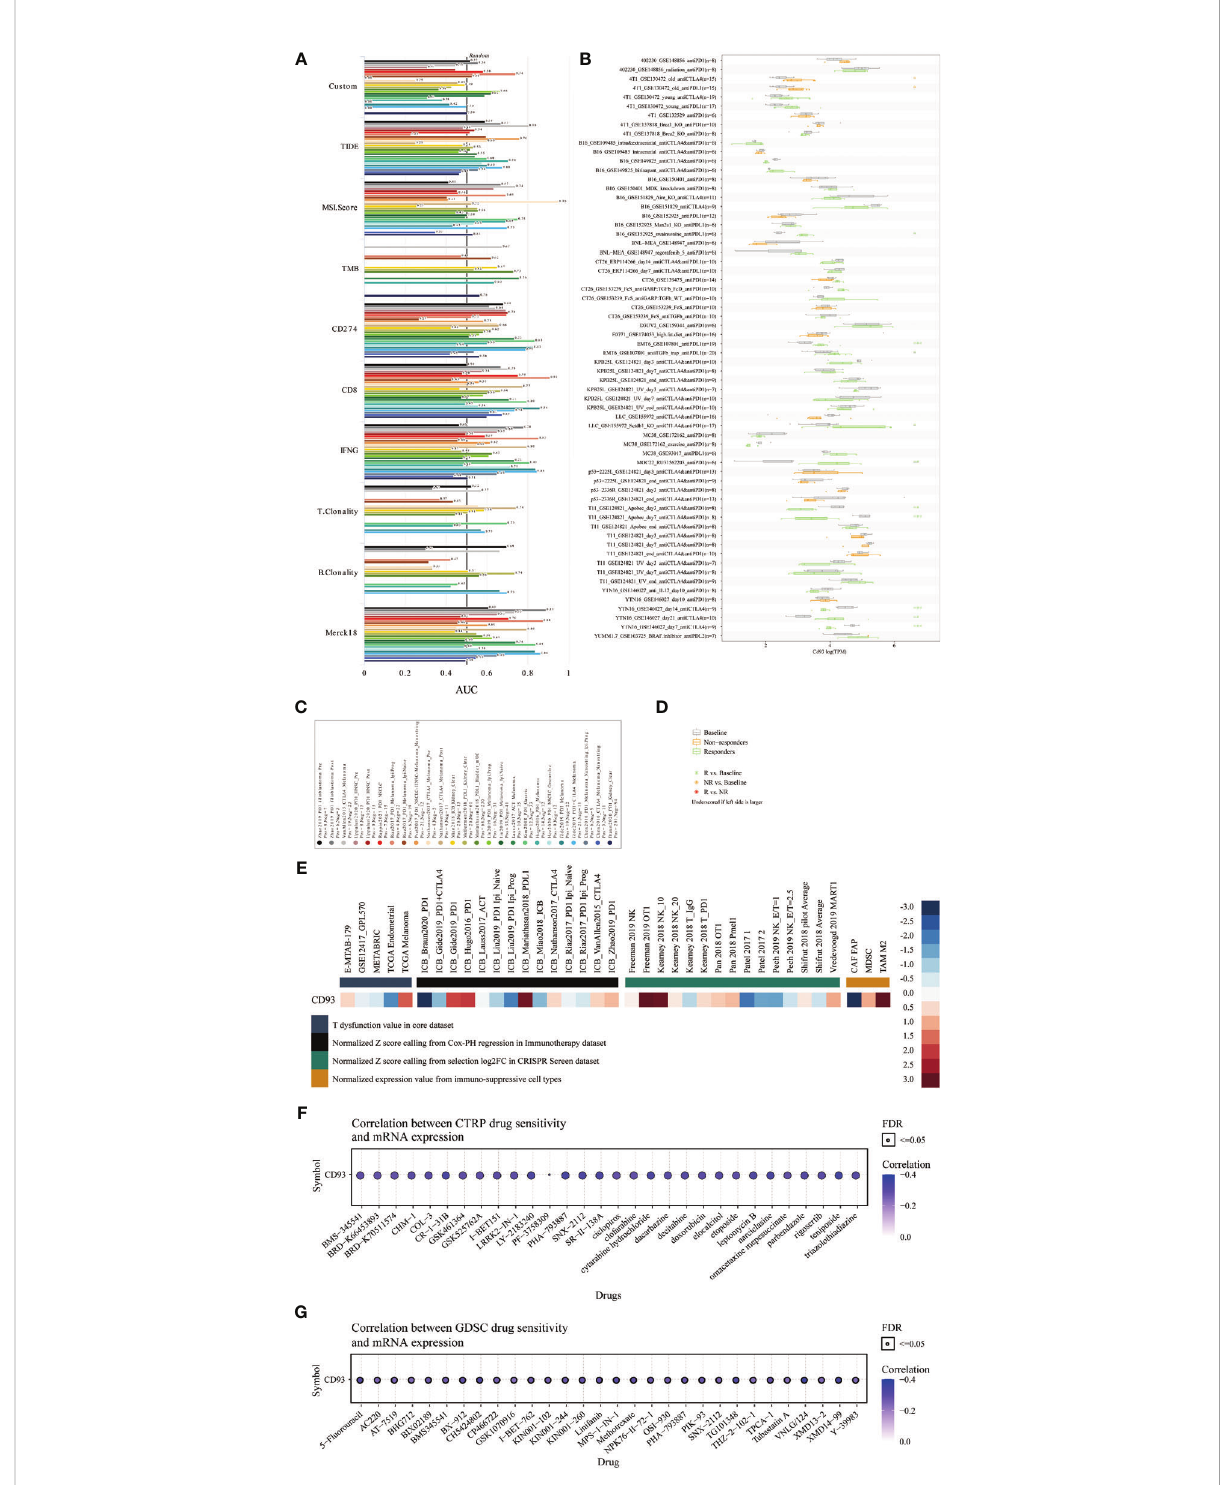
FIGURE 8 Immunotherapy value and sensitive drug prediction of CD93 based on the public datasets. Immunotherapy response (A) and biomarker relevance (B) of CD93 in immunotherapy cohorts. Notes for the immunotherapy response (C) and biomarker relevance (D) of CD93.Therapeutic responses of CD93 in mechanistic follow-up experiments in the given datasets (E) . Sensitive small compounds predicted from the CTRP (F) and GDSC (G) websites based on CD93